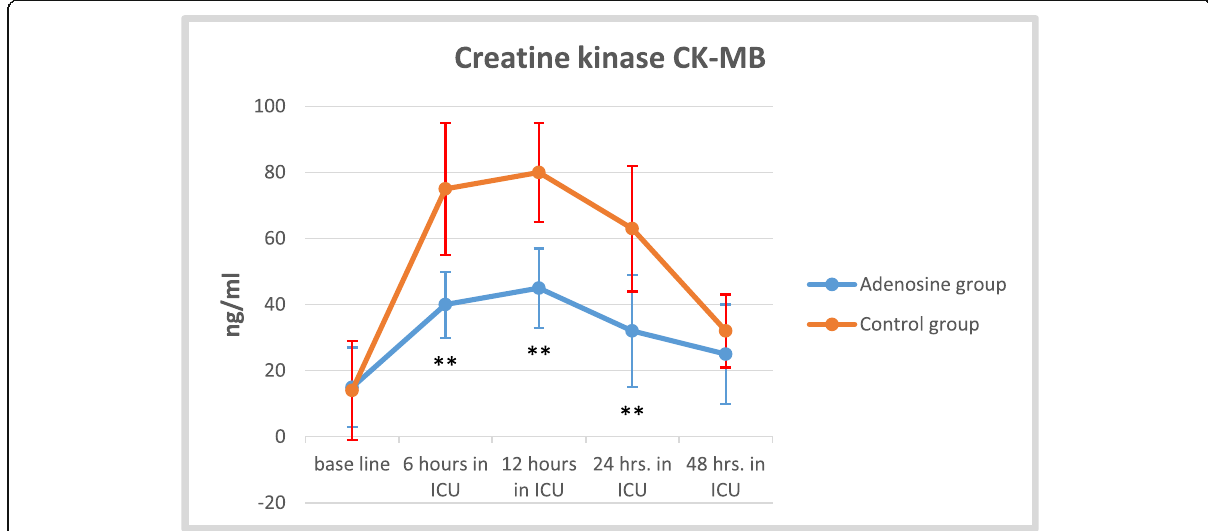
Fig. 10 Effect of adenosine on creatine kinase (CK-MB). Data were presented as mean ± SD. ** p value is highly